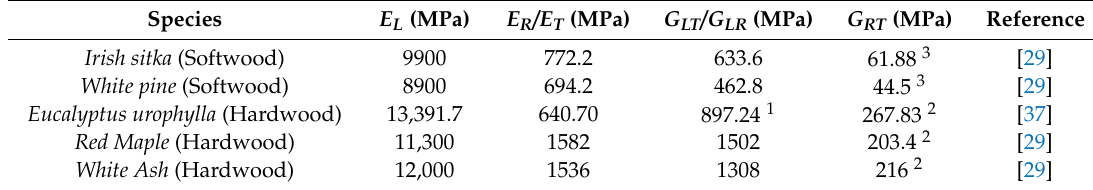
Table 6. Mechanical properties of the species of timber used for validation.